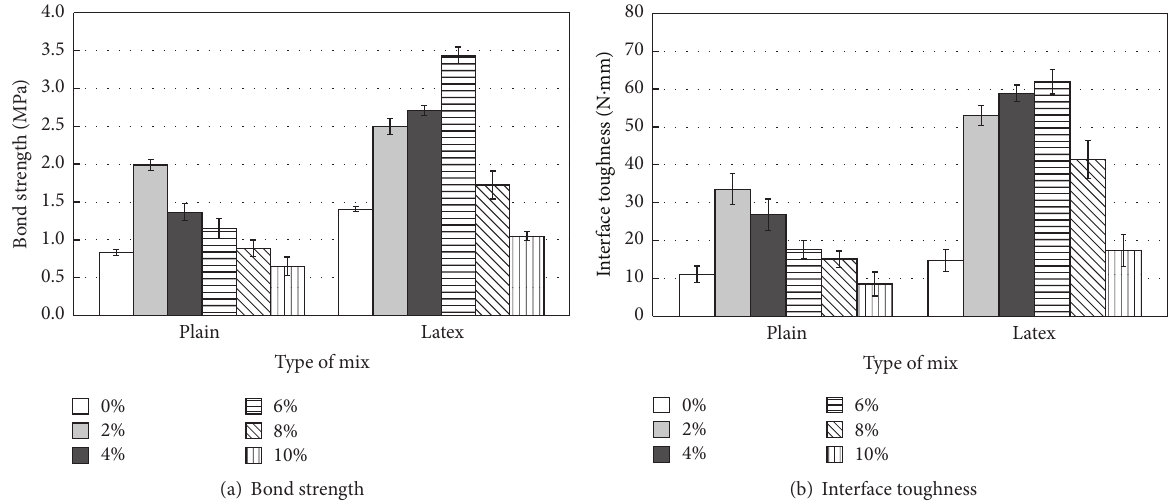
Figure 5: Bond strength and interface toughness of macro PP fiber in PCC and LCC with nanosilica